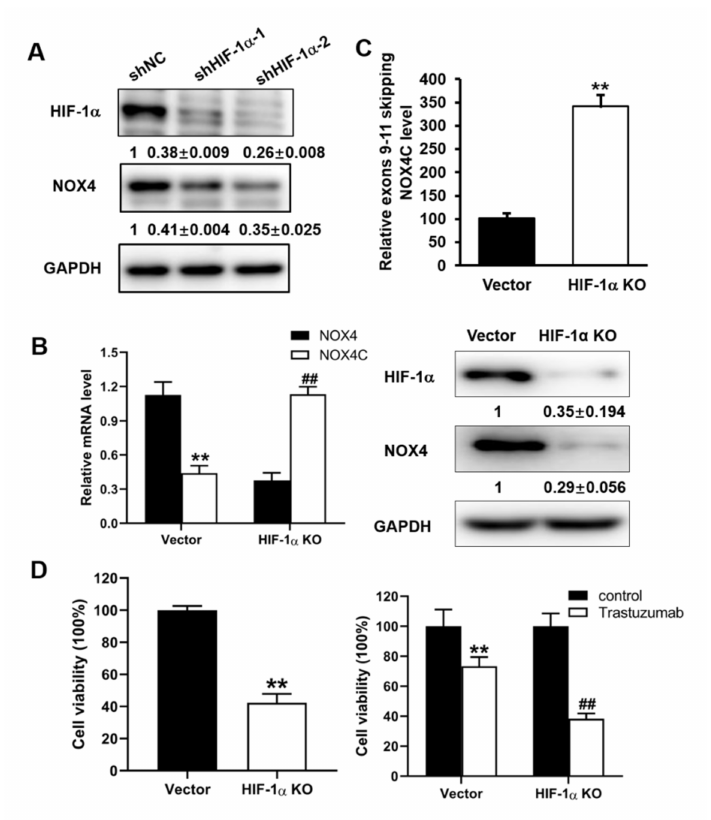
Figure 2. Expression levels of NOX4 were regulated by HIF-1 α via alternative splicing in A2780 cells. ( A ) Knockdown the expression level of HIF-1 α in A2780 cells via the shRNA of HIF-1 α (shHIF- 1 α -1 and shHIF-1 α -2) and the negative control (shNC), the expression level of NOX4 and HIF-1 α were detected and the respective pictures and the quantitative data (SEM ± SD, n = 3) are shown. ( B ) NOX4 mRNA and protein expression level in HIF-1 α knockout A2780 cells detected by RT-PCR and Western blotting. ( C ) The exons 9–11 skipping NOX4C expression levels in HIF-1 α knockout cells. ( D ) Cell viability and response to trastuzumab in HIF-1 α knockout A2780 cells. ** and ## indicates significant difference at p <